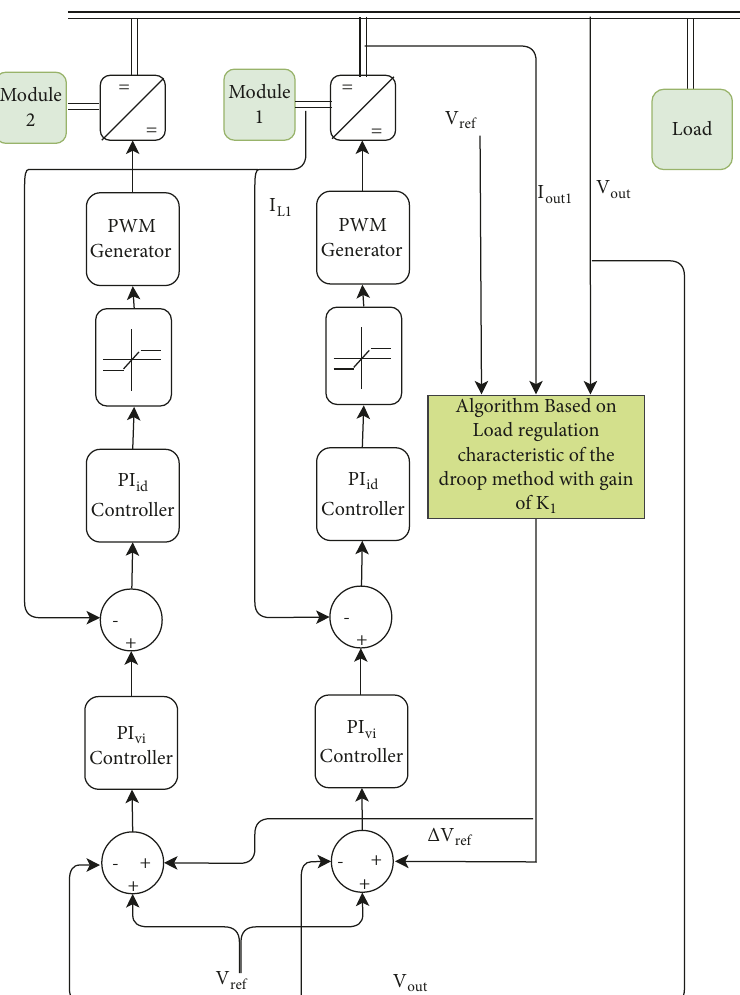
Figure 10: Block diagram of two parallel-connected converters with their control loops and the proposed algorithm.